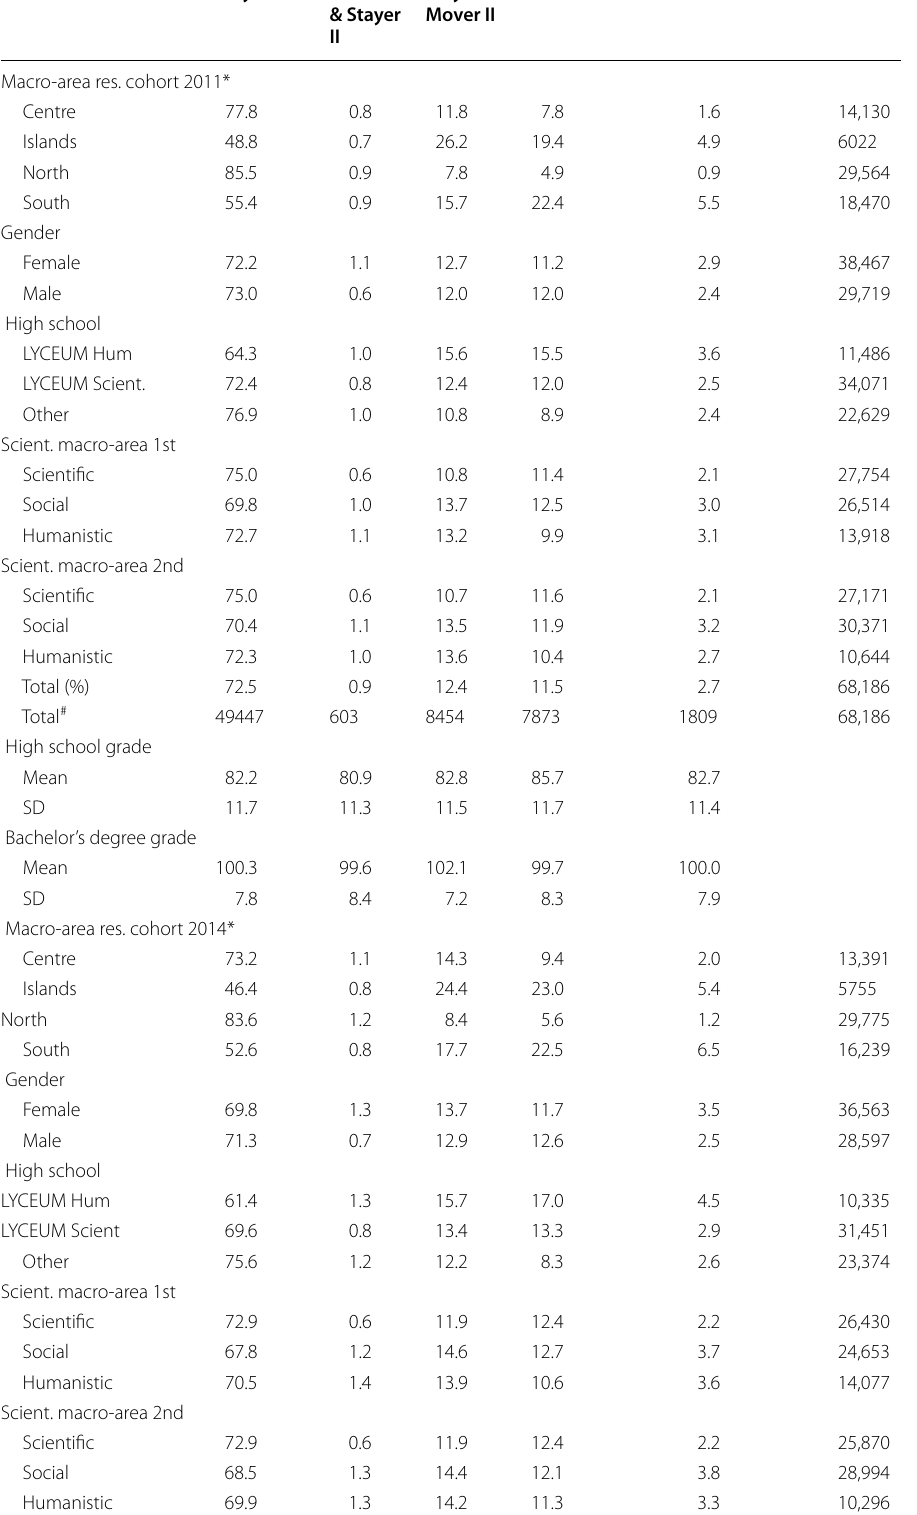
Table 2 Distribution of students in the two cohorts according to key characteristics (row %)